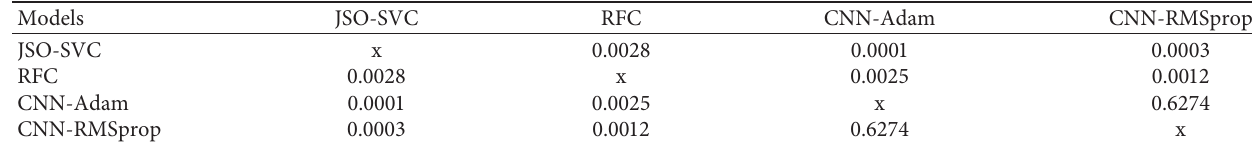
Table 4: p values obtained from Wilcoxon signed-rank test results with F 1 score index.